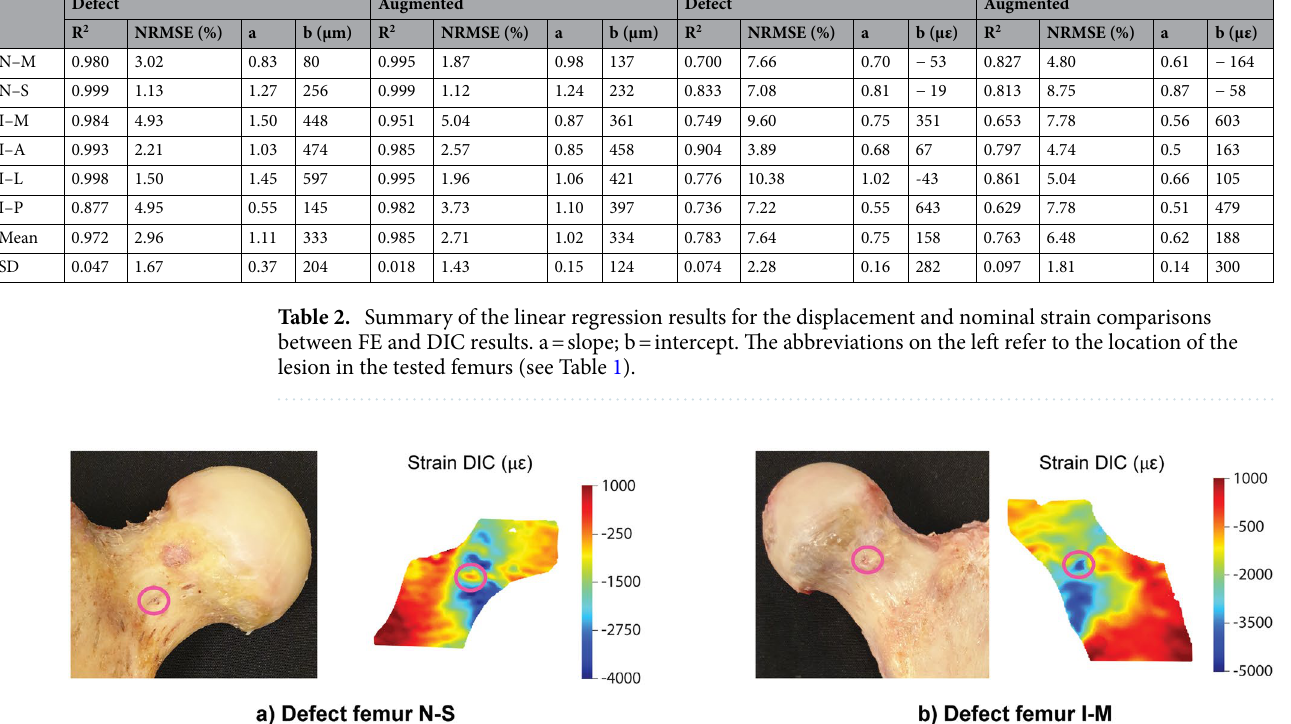
Figure 6. Local strain concentrations at vessel holes. Two examples [defect femurs from pair N–S ( a ) and pair I–M ( b )] illustrate how vessel holes can result in local strain concentrations in the DIC